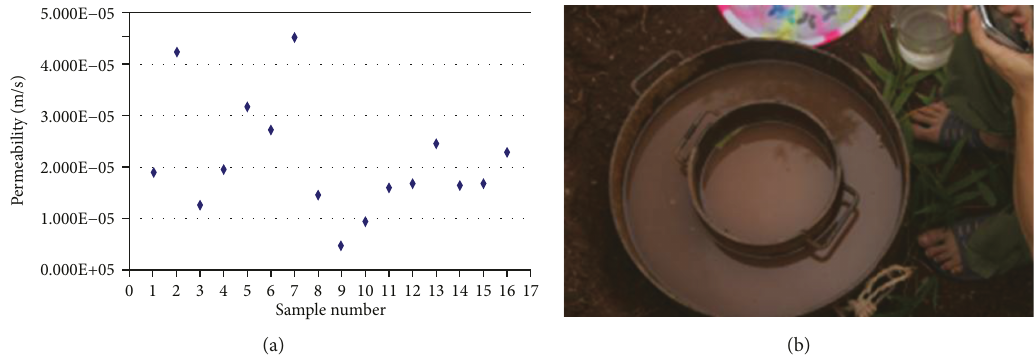
Figure 15: (a) Distribution of in situ permeability tests; (b) permeability test in the fi eld using the double-ring in fi ltrometer